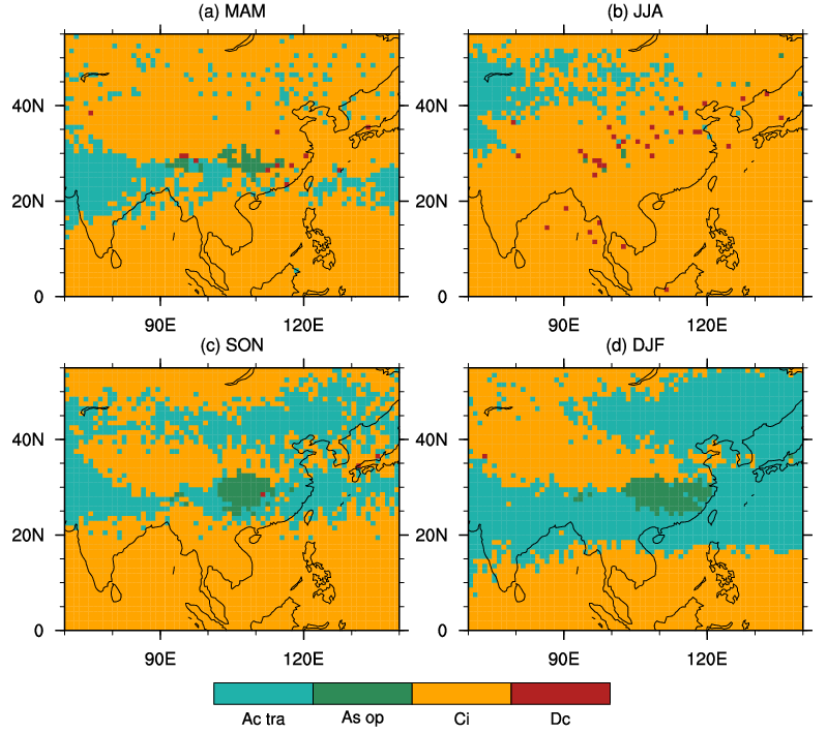
Figure 4. Distribution of prevailing cloud types in different seasons: ( a ) spring (MAM), ( b ) summer (JJA), ( c ) autumn (SON), and ( d ) winter (DJF).